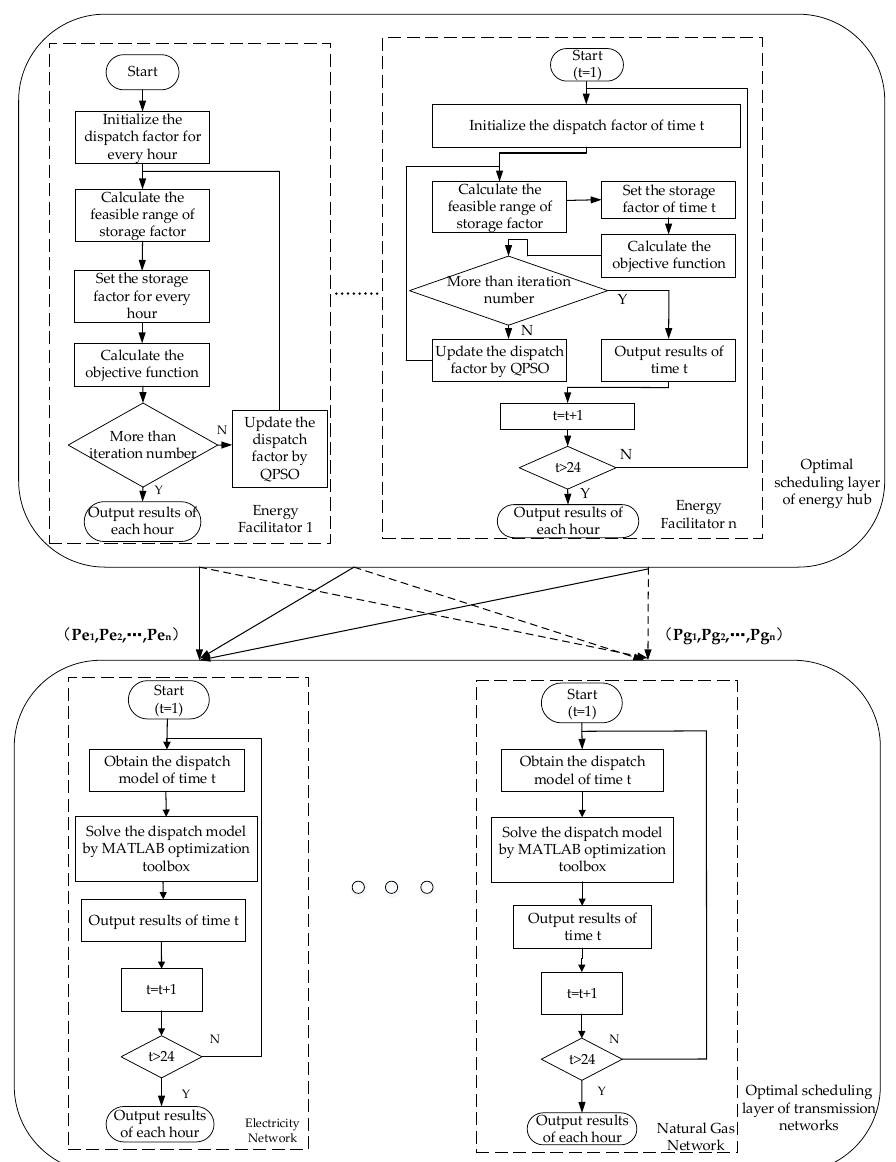
Figure 7. Solution flow chart of MECS.